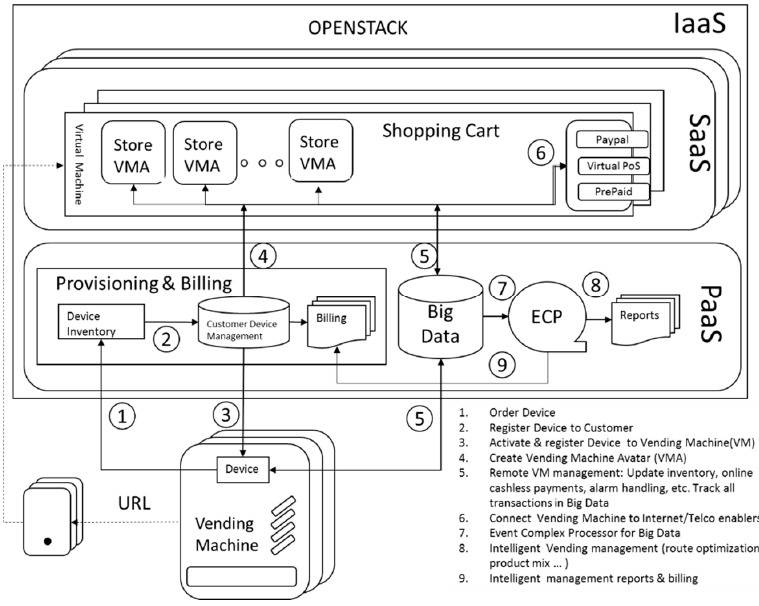
Figure 4. High level end to end system design applied to vending machines.